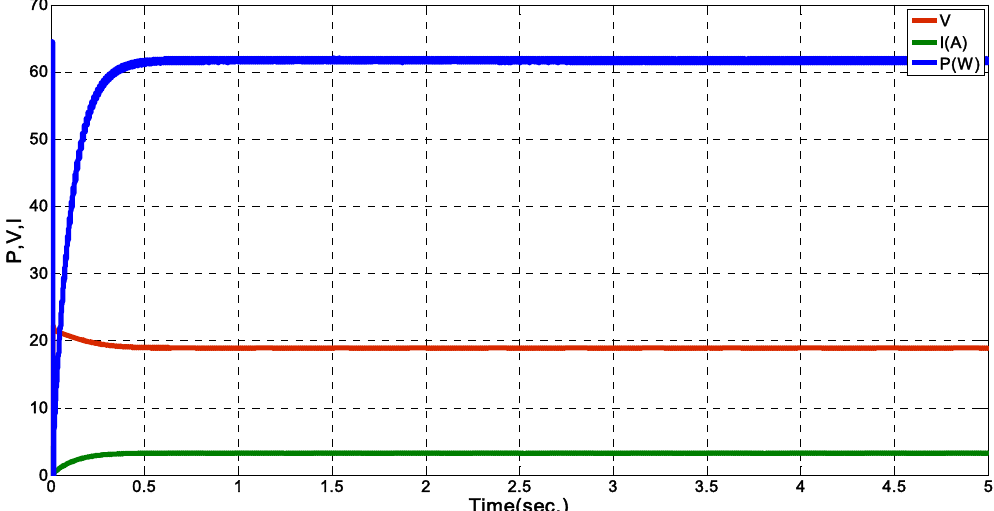
Figure 14. Time response of a SinESC system under uniform irradiance of 1 kW/m 2 at 25 °C.